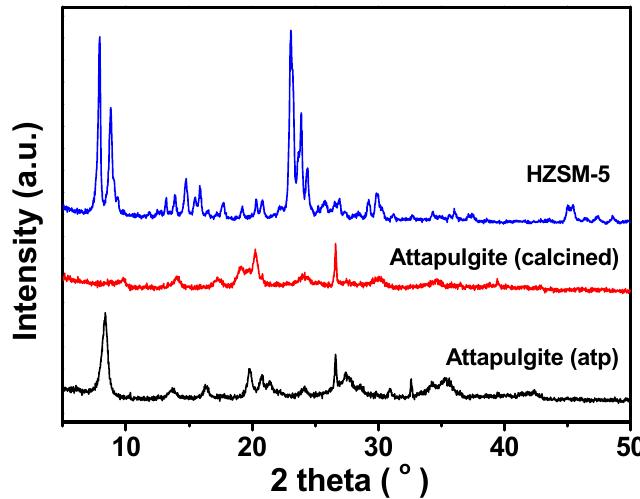
Figure 2. X-ray powder diffraction (XRD) patterns of H-ZSM-5 powder; the attapulgite binder before and after calcination